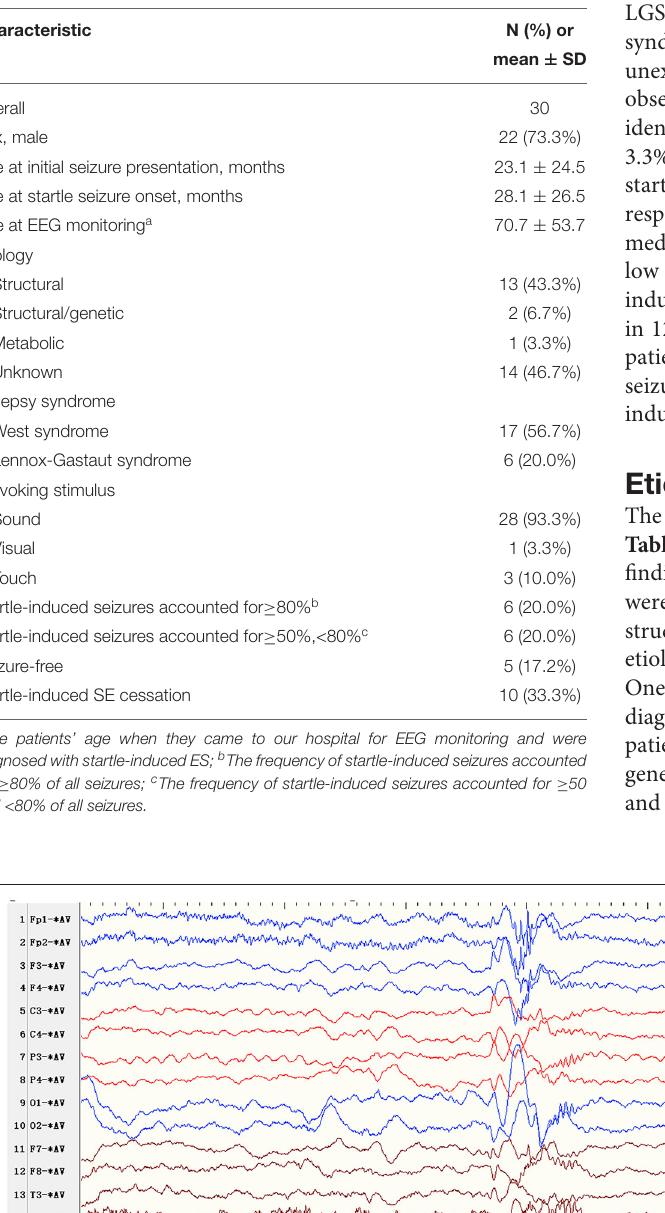
TABLE 1 | Demographic and clinical characteristics of patients.